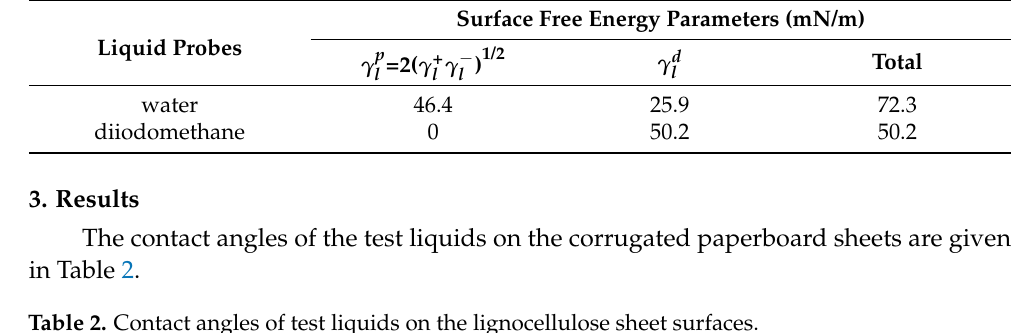
Table 2. Contact angles of test liquids on the lignocellulose sheet surfaces. Corrugated Paperboards